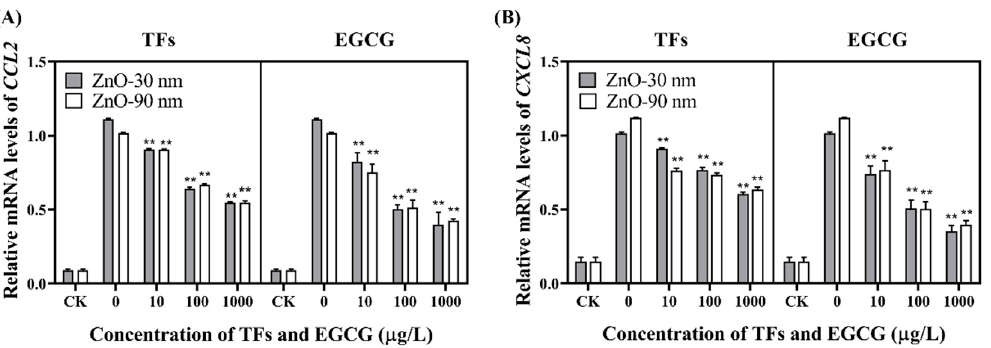
Figure 2. Cellular inflammatory response related gene expression of IL-1 β , IL-6 , and TNF- α . The effects of different concentrations of TFs and EGCG (10, 100, and 1000 µ g/L) treatment after different sizes (30 nm and 90 nm) with 100 µ g/L of ZnO-NPs exposure on the relative mRNA expressions of IL-1 β ( A ), IL-6 ( B ), and TNF- α ( C ) in RTE cells for 12 h. CK was blank group (the group with neither sample nor NPs treatment). The data was represented as the means ± standard deviation. The asterisks denoted responses that were significantly different from those of the 0 µ g/L group (** p < 0.01).